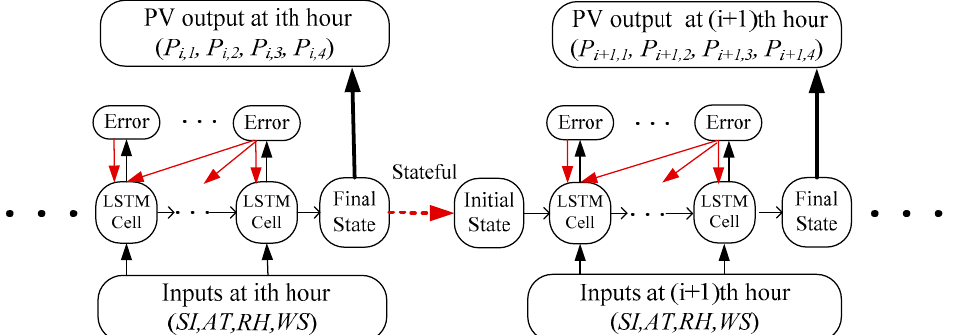
Figure 5. Diagram of PV power forecasting using LSTM.